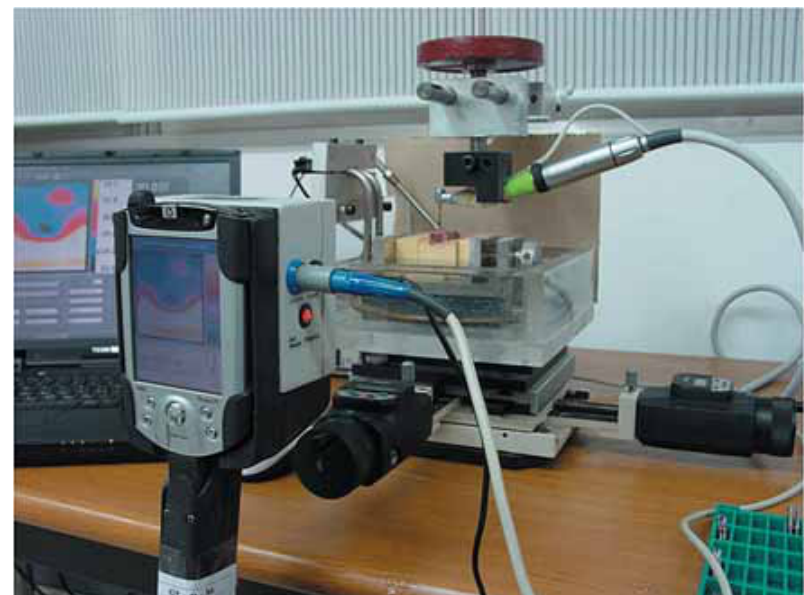
Figure 2- Infrared thermography measured the temperature changes